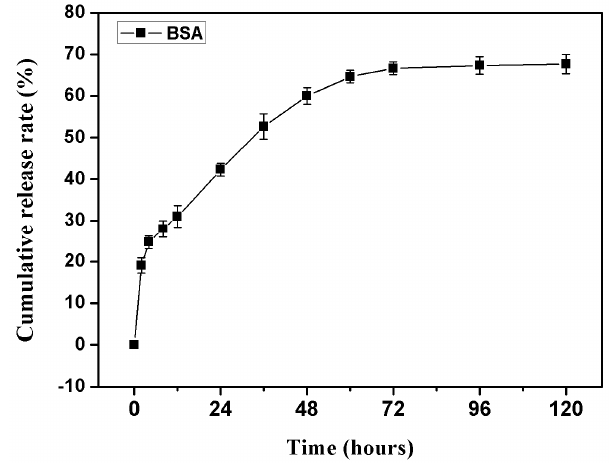
Figure 2. Cumulative release rate of bovine serum albumin (BSA) per time point from sodium alginate